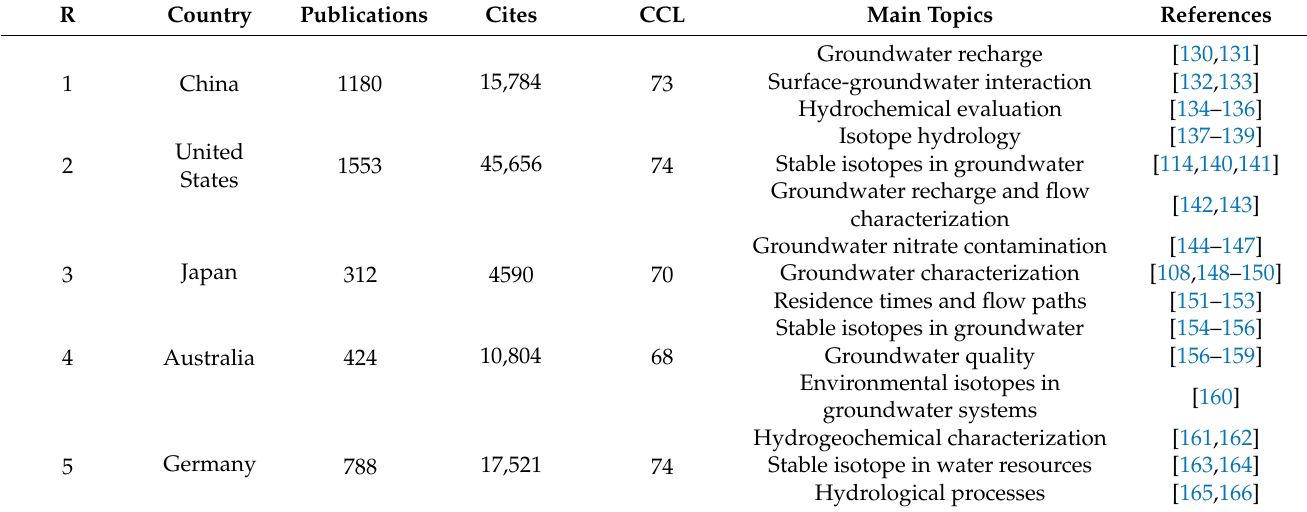
Table 2. Main Countries Collaboration about